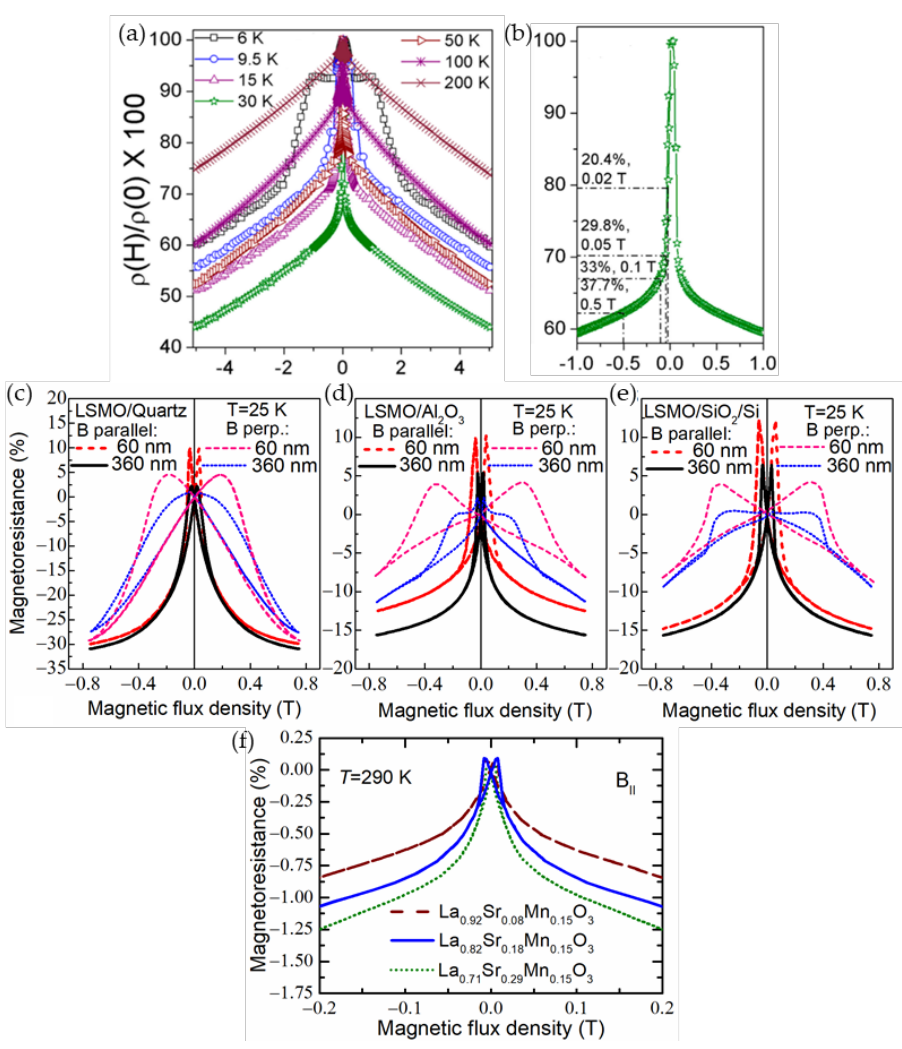
Figure 7. Normalized resistance as a function of applied field at different temperatures ( a ); and low- field magnetoresistance at 30 K ( b ) for La 0.71 Sr 0.29 MnO 3 nanoparticles synthesized by nonaqueous sol – gel route. Reprinted with permission from [67], copyright 2014 American Chemical Society; ( c ); ( d ); ( e ) Low-field magnetoresistance dependences on magnetic flux density for different thickness films (60 nm and 360 nm) grown on different substrates. Measurements performed at ambient tem- perature of 25 K. Reprinted from [68], copyright 2022 MDPI; and ( f ) MR vs. magnetic field depend- ences at room temperature for nanostructured La 1-x Sr x Mn y O 3 films with different Sr content x and constant Mn excess y = 1.15. Reprinted from [69], copyright 2022